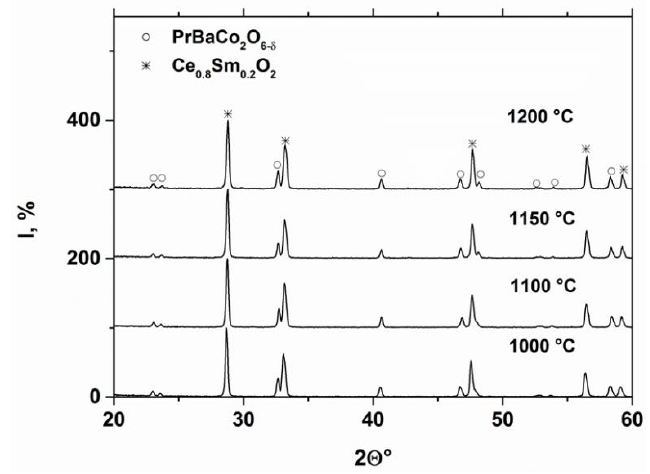
Figure 3. The XRD patterns of PrBaCo 2 O 6 − δ –Ce 0.8 Sm 0.2 O 1.9 (50:50 wt.%) mixtures calcined at different temperatures for 12 h in air.